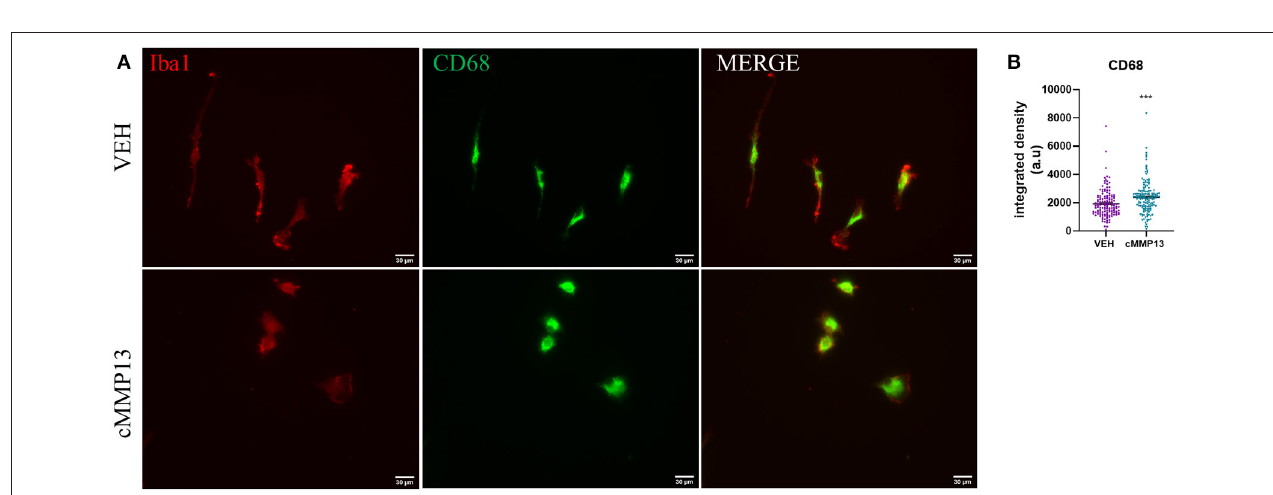
FIGURE 9 | cMMP13-stimulated microglia increased the lysosomal marker, CD68. (A) CD68 (green) and Iba1 (red) immunofluorescence was conducted after 24h of 20nM cMMP13 or vehicle treatment of microglia. (B) CD68 total fluorescent signal was elevated in cMMP13-treated microglia; n = 143 VEH cells and n = 152 cMMP13 cells. Values are reported as mean ± SEM, using an unpaired Student’s t -test; *** P ≤